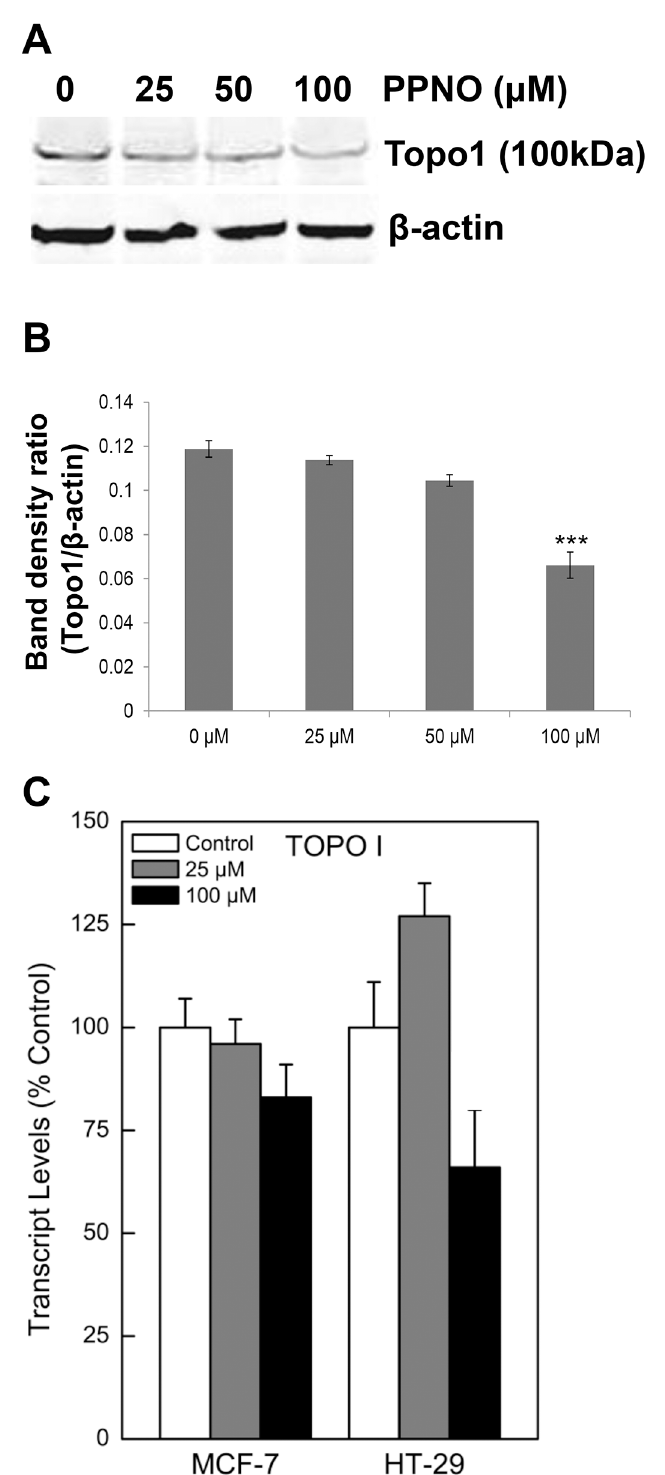
Fig 1. (cid:1) NO-induced down-regulation of topo I protein levels in HT-29 cells. (A) HT-29 cells were treated with various concentrations of PPNO for 6 h as described in the Methods section. Cells were collected, lysed and analyzed by Western blots for topo I. (B) Quantification of topo I protein levels relative to actin, and (C) Transcript levels of the topo I gene in HT-29 and MCF-7 cells. Transcript levels were determined as described in the Methods section using actin as the